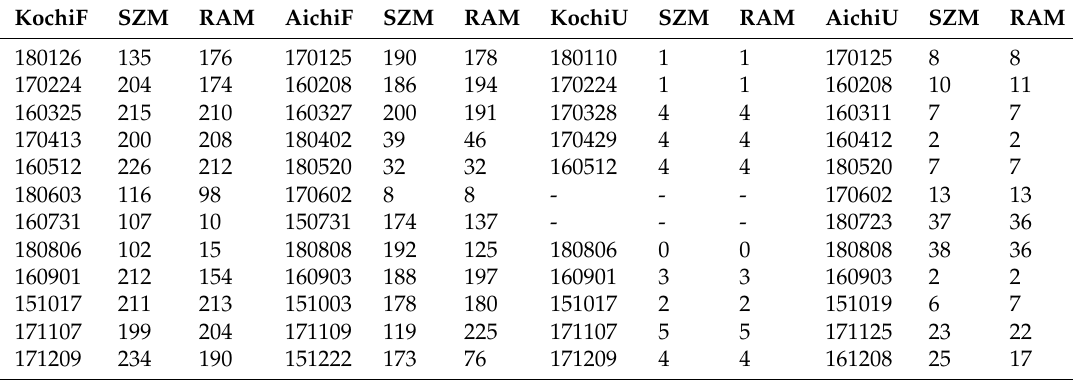
Table 6. Number of pixels paired for comparison after all screening processes had been applied. Dates are represented by six digits: